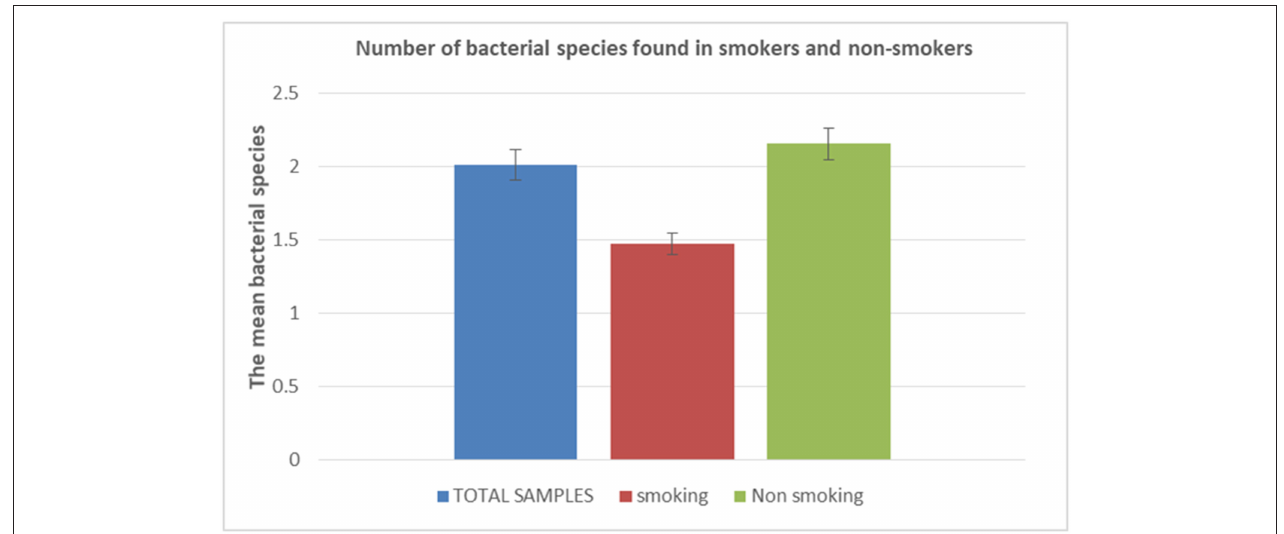
FIGURE 1 | Number of bacterial species found in tobacco smokers and non-smokers. The histogram is showing the mean number of bacterial species accordingly to tobacco smoking/non-smoking status. In blue characters: Total number of samples; in red characters: total number of smoker samples; in green characters: total number of non-smoker samples.